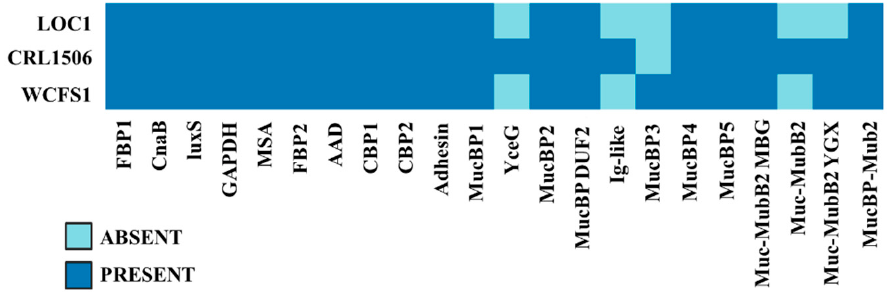
Figure 10. Analysis of the presence/absence of genes involved in adhesion in Lactiplantibacillus plantarum LOC1. The genome of the LOC1 strain was studied and compared with the probiotic strains WCFS1 and CRL1506 as reference.